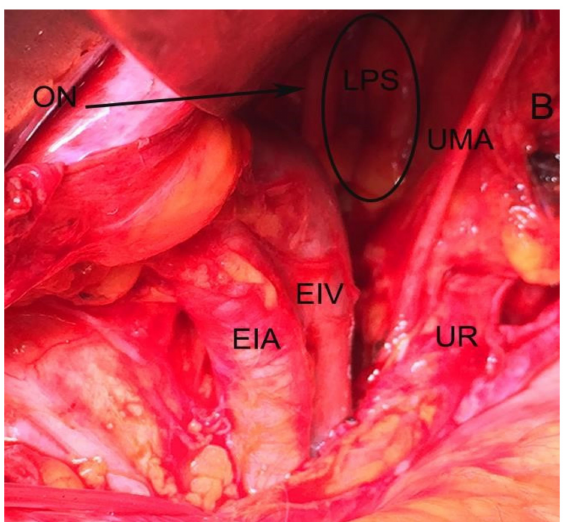
Figure 4. Lateral paravesical space dissected by open surgery (left side of the pelvis). LPS—lateral paravesical space; ON—obturator nerve; UMA—obliterated umbilical artery; UR—ureter; EIV— external iliac vein; EIA—external iliac artery;